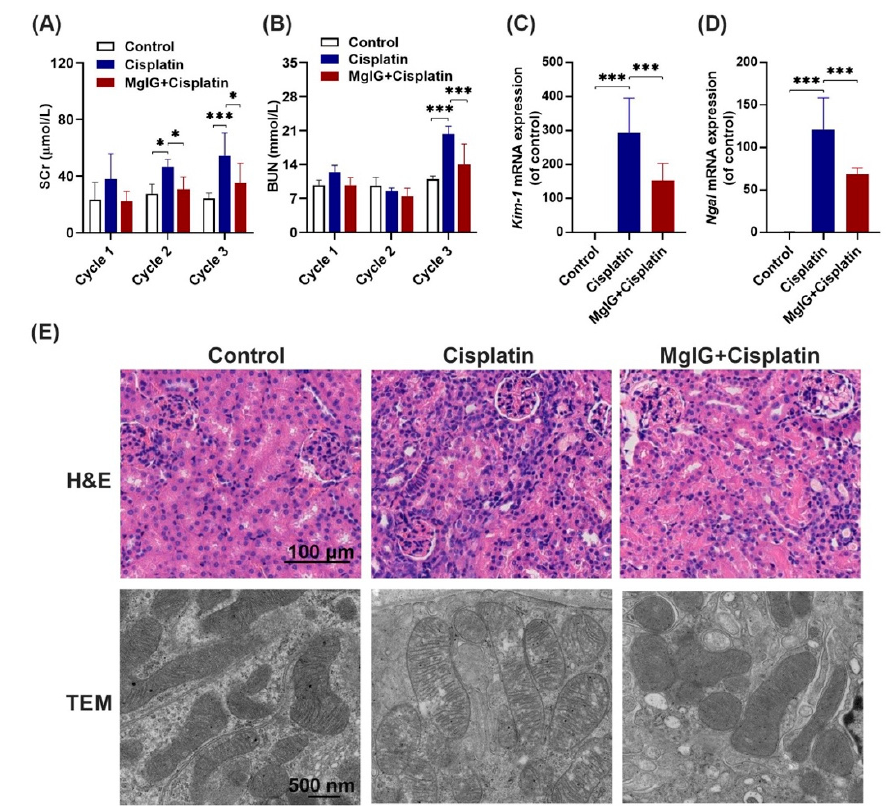
Figure 2. MgIG significantly ameliorates cisplatin-induced renal injury. ( A , B ) The levels of SCr and BUN in mice over 3 cycles. ( C , D ) The mRNA expression levels of KIM-1 and NGAL in mouse kid- neys at the end of cycle 3. Combination with MgIG attenuated the elevation of SCr, BUN, KIM-1, and NGAL caused by cisplatin in mice. ( E ) Representative H&E staining of renal mouse tissue (scale bar = 100 μ m) and TEM micrographs of renal tubular epithelial cell mitochondria (scale bar = 500 nm) from each group. Co-treatment with MgIG prevented mitochondrial ultrastructural abnormal- ities in renal tubules against cisplatin. The data are presented as the mean ± SD, n = 8. * p < 0.05, *** p < 0.001.